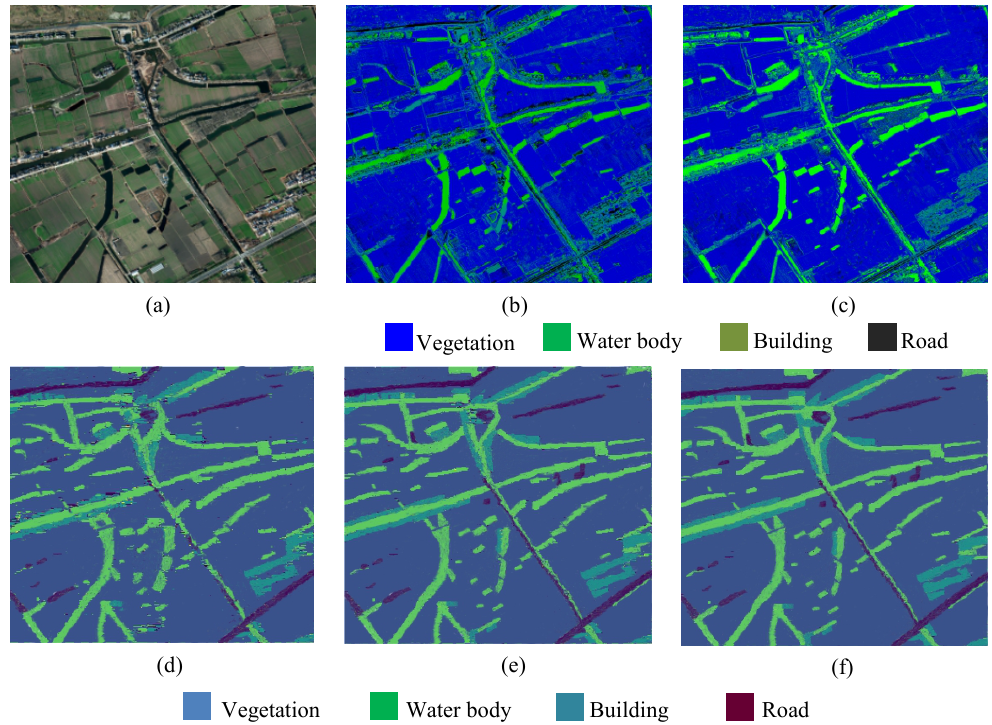
Figure 6. Classification results of remote sensing image (a) by ML (b), SVM (c), CNN (d), SegNet (e) and GA-SegNet